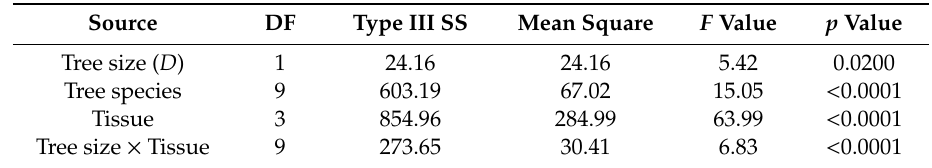
Table 1. The e ff ects of tree size ( D ), tree species, and tissue on tissue-specific carbon concentrations of the 10 tree species. The columns give the degrees of freedom (DF), type III sum of squares, and mean square, F values, and p values.